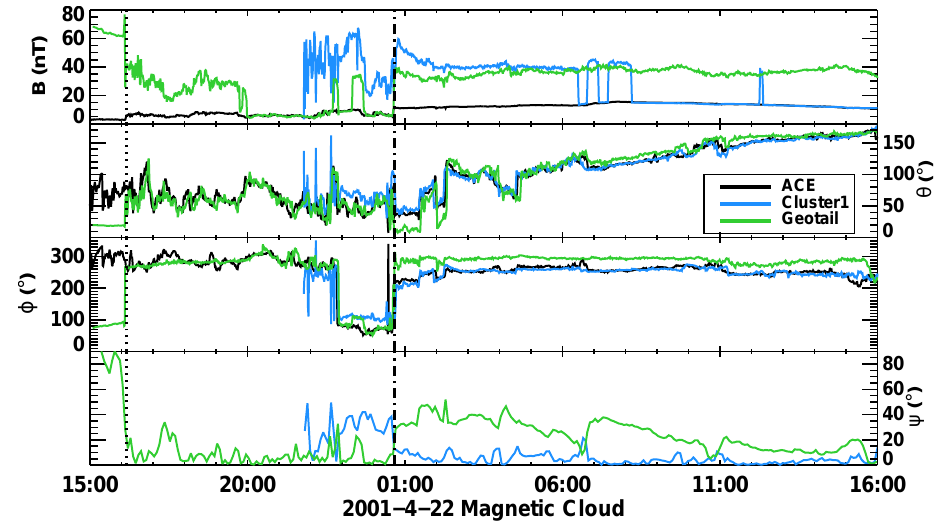
Figure 4. 22 April 2001 MC: observations from ACE (black), Cluster (blue) and Geotail (green), in GSE coordinates. Same format as Fig.